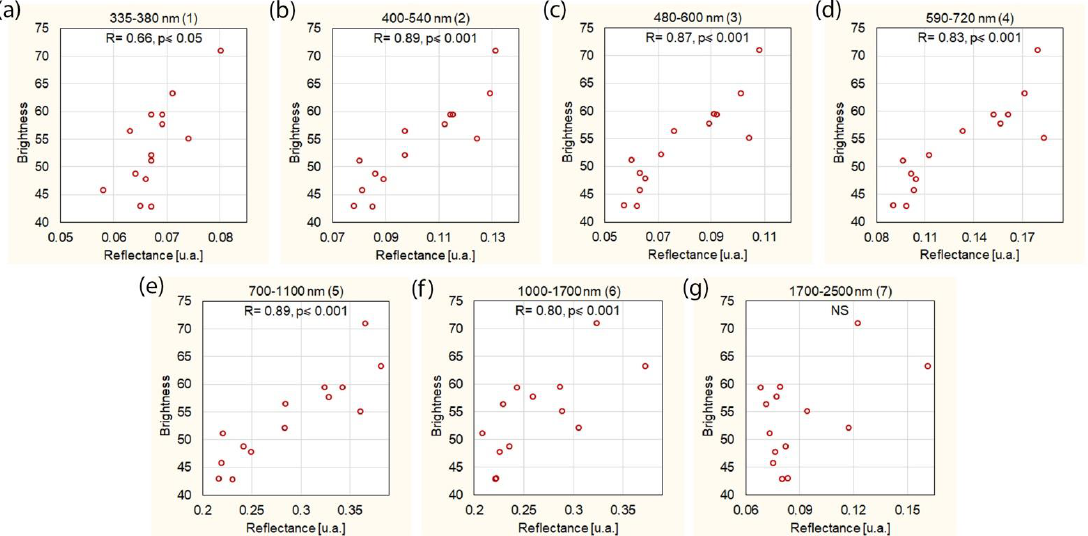
Figure 4. Correlation between chocolate brightness and reflectance for different wavelength ranges: ( a ) 335 – 380 nm, ( b ) 400 – 540 nm, ( c ) 480 – 600 nm, ( d ) 590 – 720 nm, ( e ) 700 – 1000 nm, ( f ) 1000 – 1700 nm, ( g ) 1700 – 2500 nm. NS — not significant.